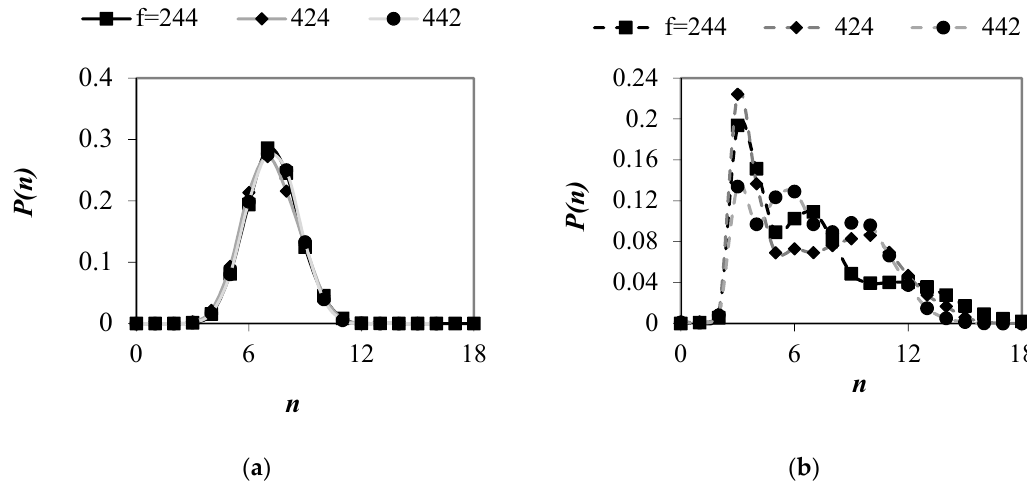
Figure 13. Probability distributions for the number of contacts per particle in mixtures with g = 1.25 ( a ) and g = 3.75 ( b ) and various f values, under vertical load of 100 kPa.